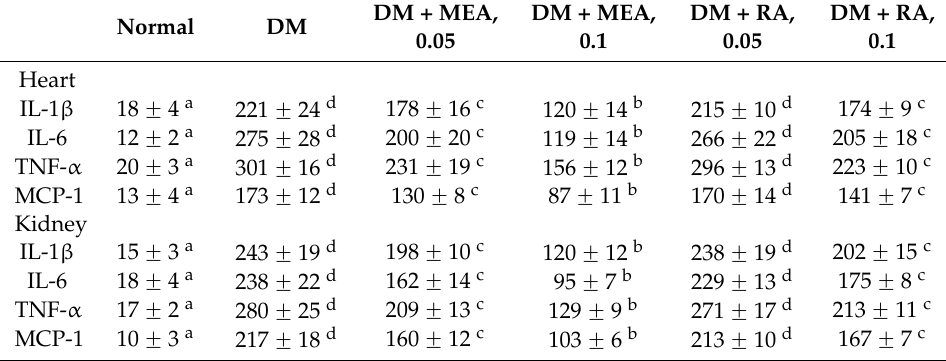
Table 5. Levels (pg/mg protein) of IL-1 β , IL-6, TNF- α and MCP-1 in heart and kidney from normal (non-diabetic), diabetic mice consumed normal diet (DM), or 0.05%, 0.1% MEA or RA for six weeks. Data are mean ˘ SD, n =